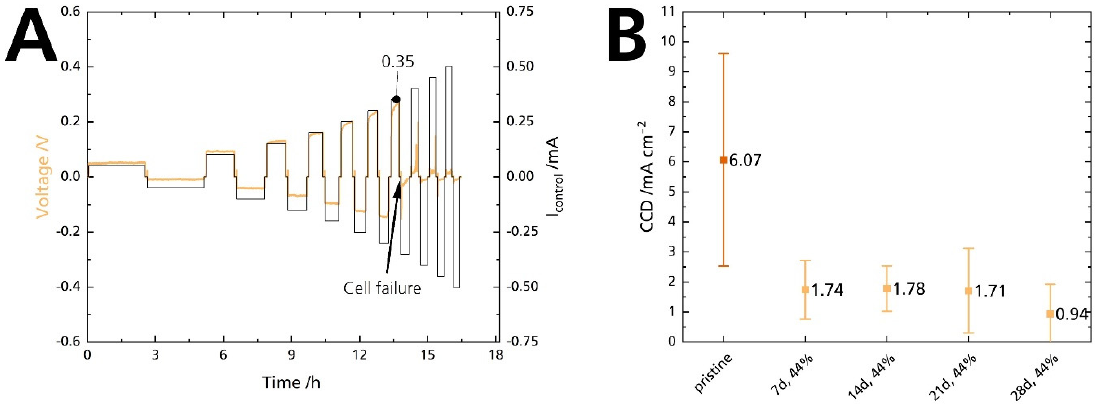
Figure 14. ( A ) CCD measurement of a Na|BASE|Na cell. The BASE was stored in 44% r.h. for 14 days. ( B ) Comparison of the CCD experiment at 25 °C for a cycled areal capacity of 0.25 mAh cm − 2 in symmetrical Na|BASE|Na cells. The error bars represent standard deviations.